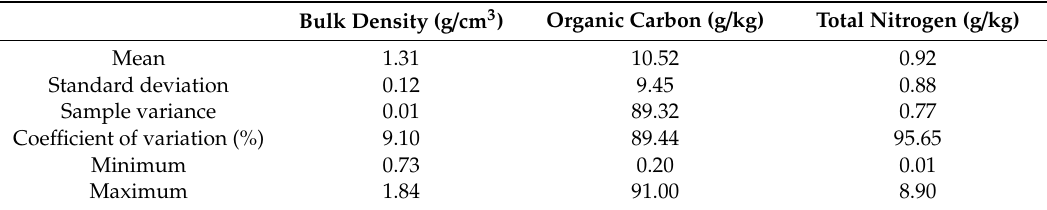
Table 2. Descriptive statistics of soil health indicators in